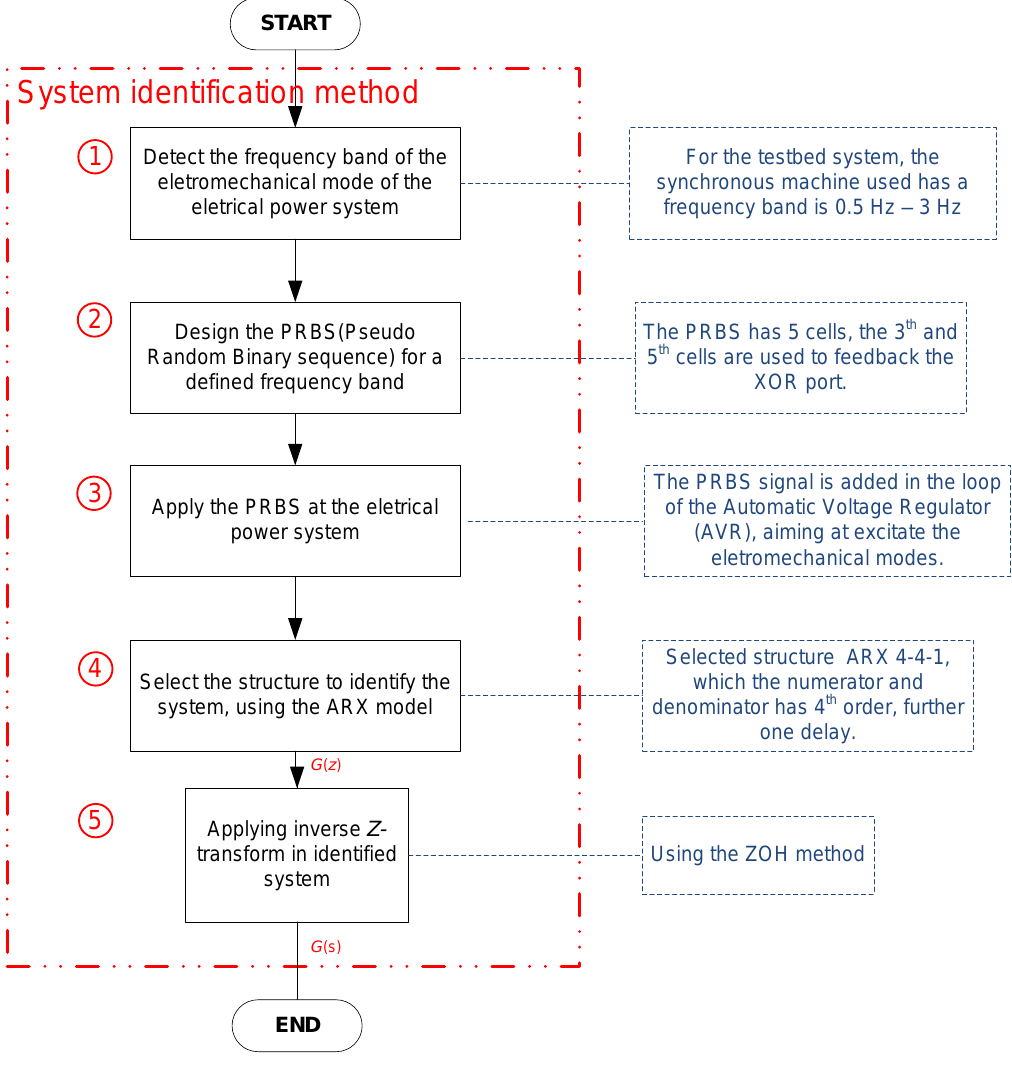
Figure 8. Flowchart describing the identification methodology.